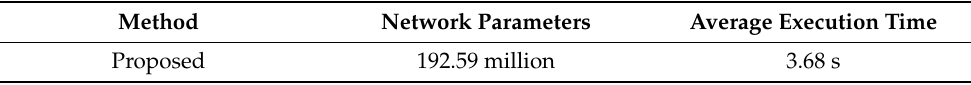
Table 5. Execution time and network parameters of the proposed